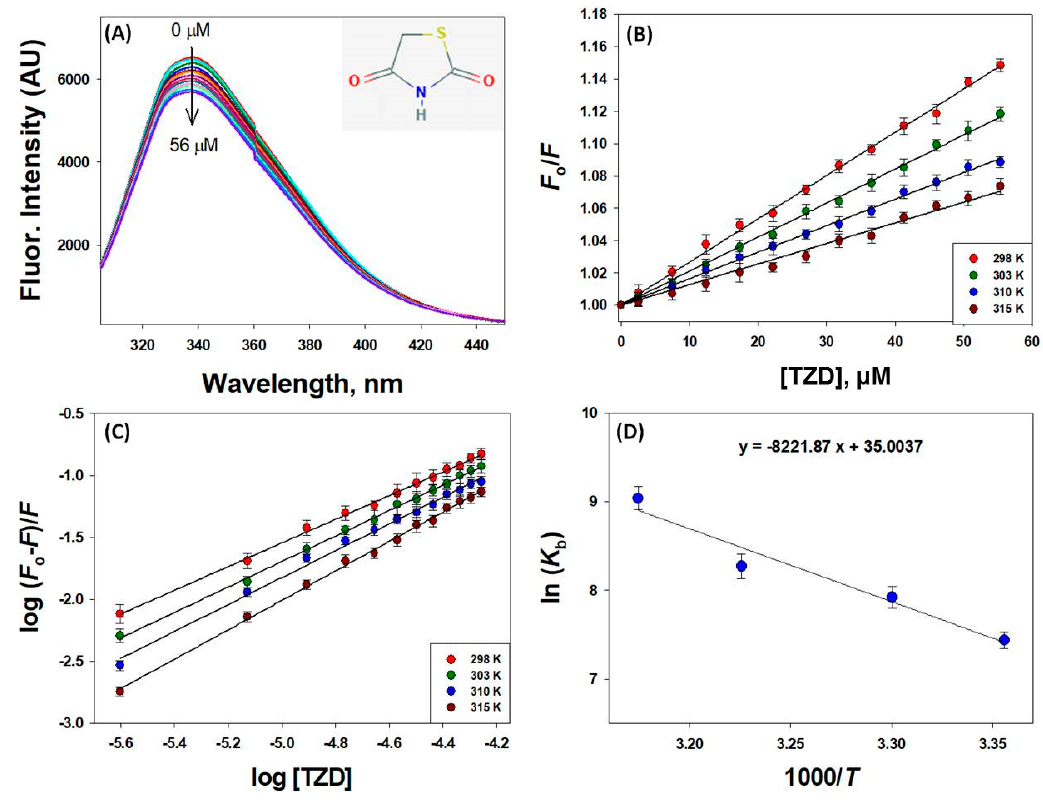
Figure 1. Intrinsic fluorescence of HSA in the presence of 2,4-TZD at different temperatures. ( A ) Fluorescence quenching as a function of 2,4-TZD concentration at 298 K. The inset shows the structure of 2,4-TZD, ( B ) Stern-Volmer plot of HSA quenching by 2,4-TZD, ( C ) Double logarithm or modified Stern-Volmer plot, and ( D ) a van’t Hoff plot, which was used to calculate thermodynamic parameters. n = 3.